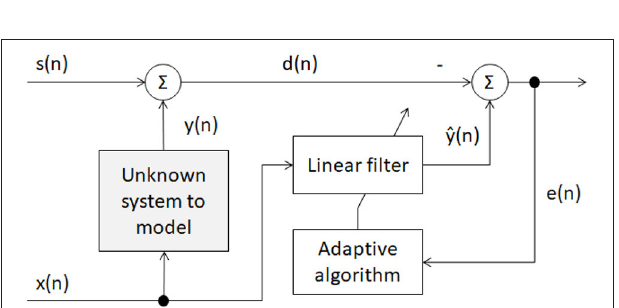
FIGURE 4 | Block diagram of proposed adaptive